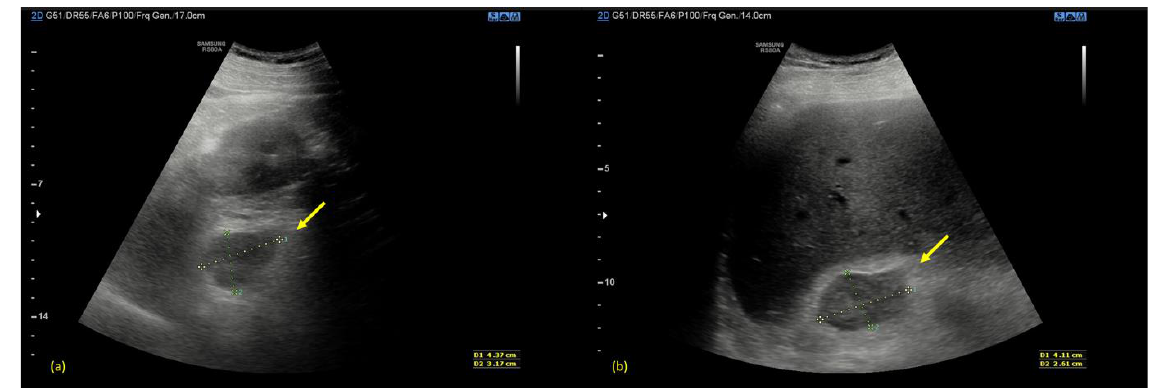
Figure 1. ( a ) Arrow indicates the right adrenal gland. ( b ) Arrow indicates the left adrenal gland. The US Scan shows an enlargement of both adrenal glands with inhomogeneous echogenicity. The right gland measures 41 × 26 mm while the left adrenal gland measures 43 × 30 mm.